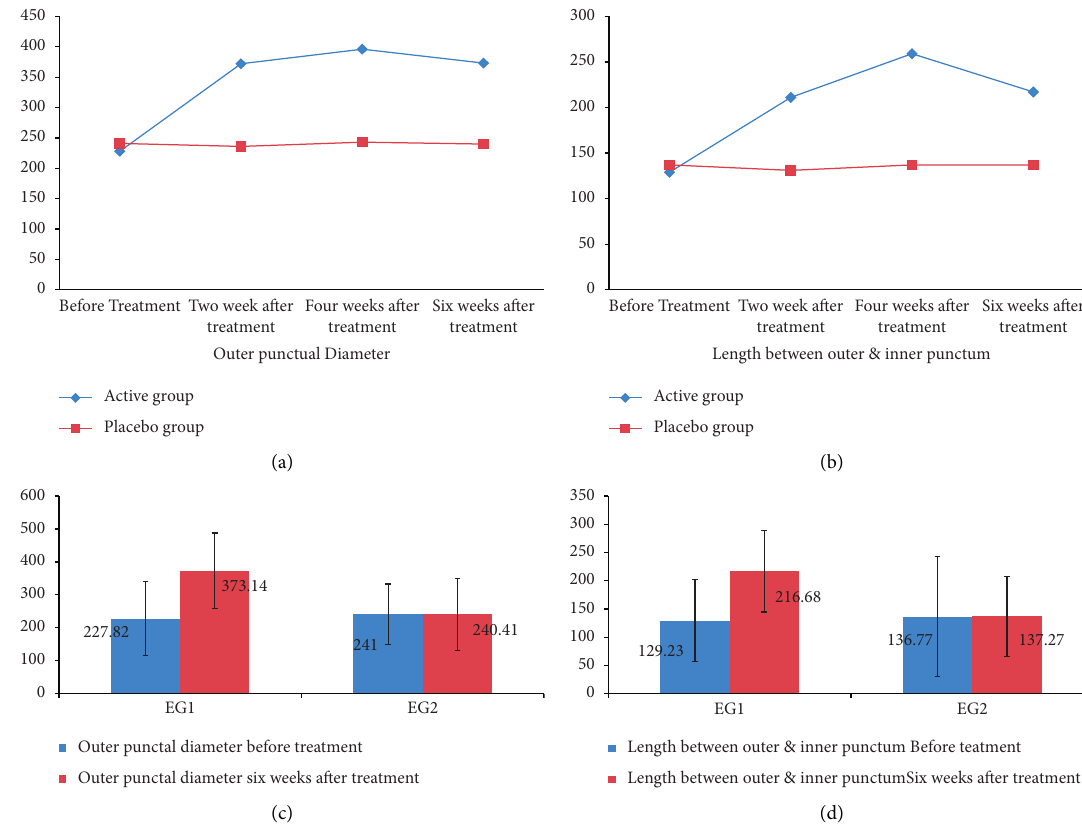
Figure 1: Comparison of outer diameter and the length of the lower punctum between both groups before treatment and during the follow- up